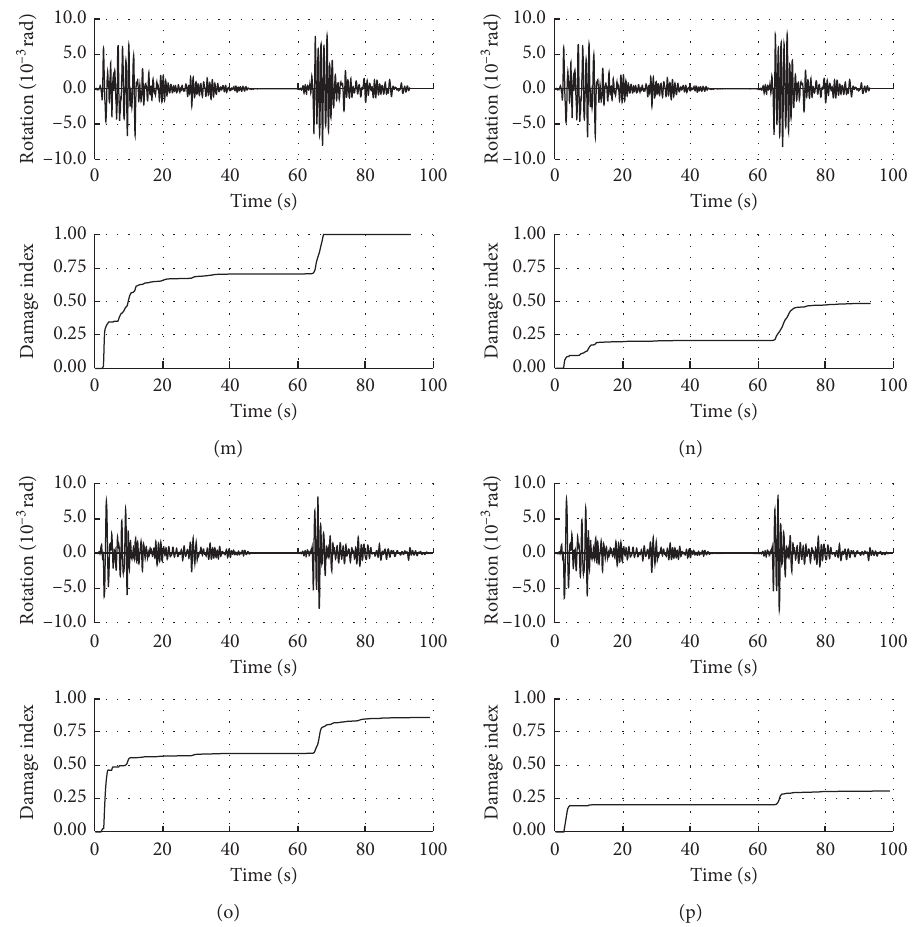
Figure 8: Variations of damage indices during seismic sequences. (a) Original frame under sequence 1. (b) FRP-retrofitted frame under sequence 1. (c) Original frame under sequence 2. (d) FRP-retrofitted frame under sequence 2. (e) Original frame under sequence 3. (f)